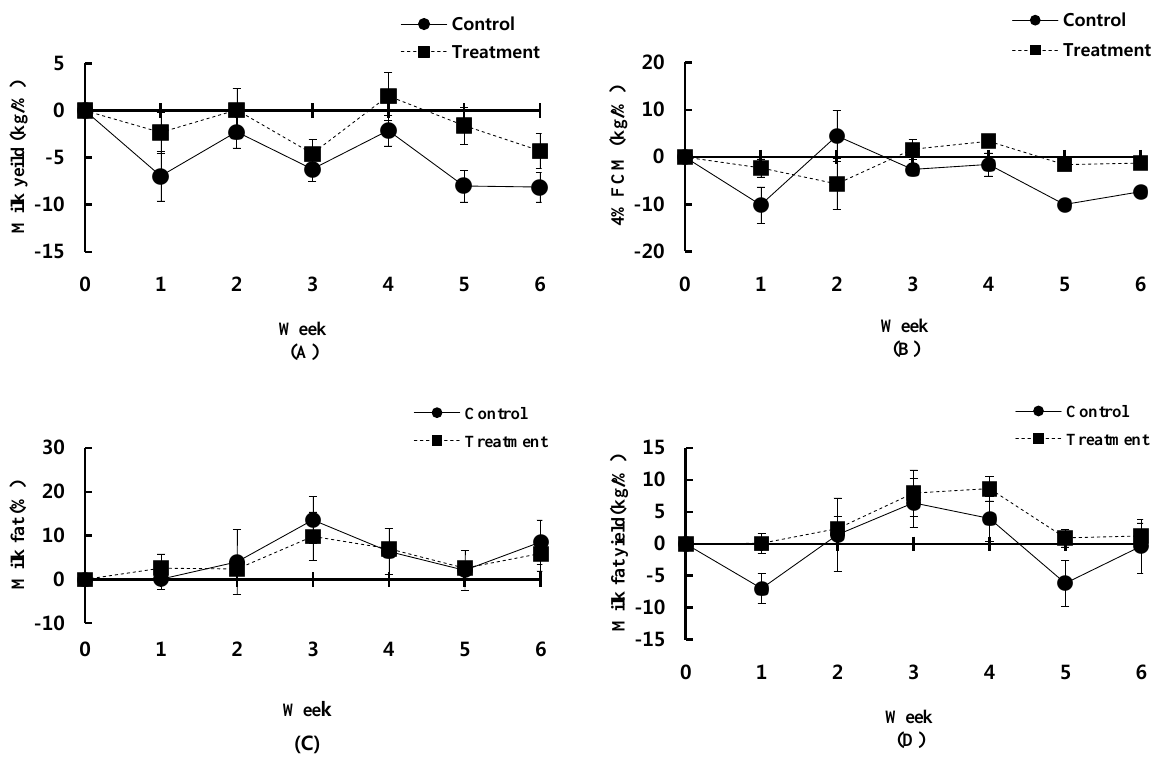
Figure 1. i) Effect of RPAAs and RPF supplementation on milk (A) yield (kg/%), (B) 4% fat corrected milk (FCM) (kg/%), (C) fat (%), (D) fat yield (kg/%), (E) protein (%), (F) protein yield (kg/%), (G) MUN (milk urea nitrogen) yield (mg/dL/%) of Holstein-Frisian dairy cows (Index against 0%). Control group fed basal diet only (no addition of RPAAs and RPF), and the treatment group fed basal diet with 50 g of RPAAs (50% of RPLys and RPMet [3:1 ratio]) and 50 g of RPF ( 98% of RPF ) twice a day (total 100 g of each RPAAs and RPF/d). RPAAs, ruminally protected amino acids; RPF, ruminally protected fat; RPLys, ruminally protected lysine; RPMet, ruminally protected